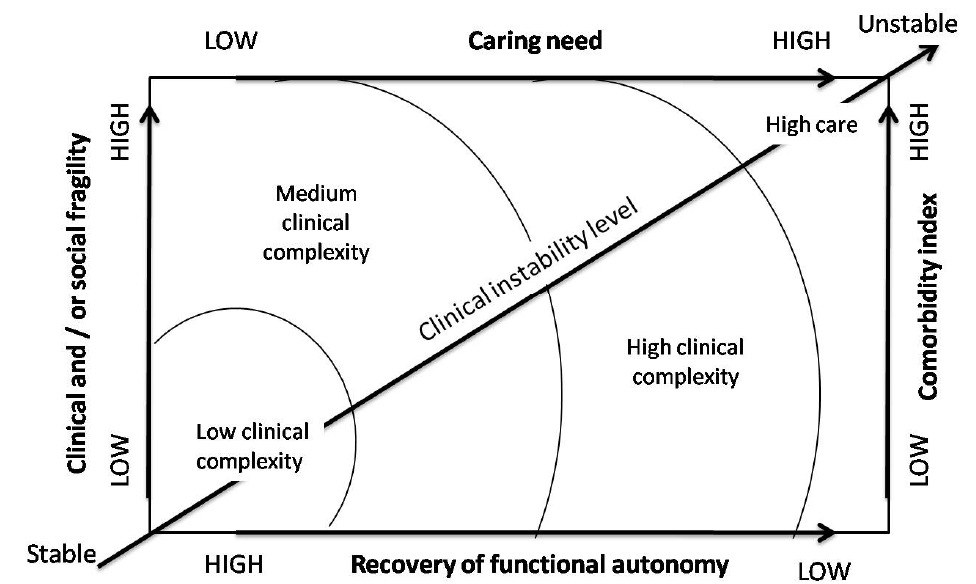
Figure 1. Model of the variables that make up the clinical care complexity. Source: Nardi et al. [17].